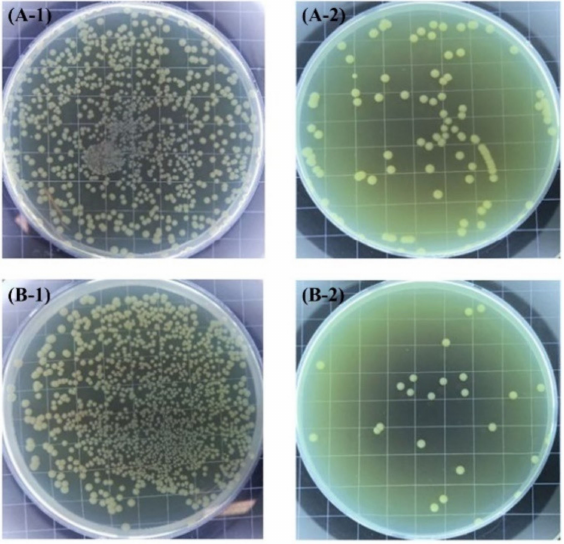
Figure 6. ( A ) Anti- S. aureus; and ( B ) anti- E. coli assay of untreated ( − 1) and copper nanoparticles (Cu NPs) ( − 2) surfaces. Figure derived from the work of Cao et al. (Reproduced from [86], published by John Wiley and Sons,